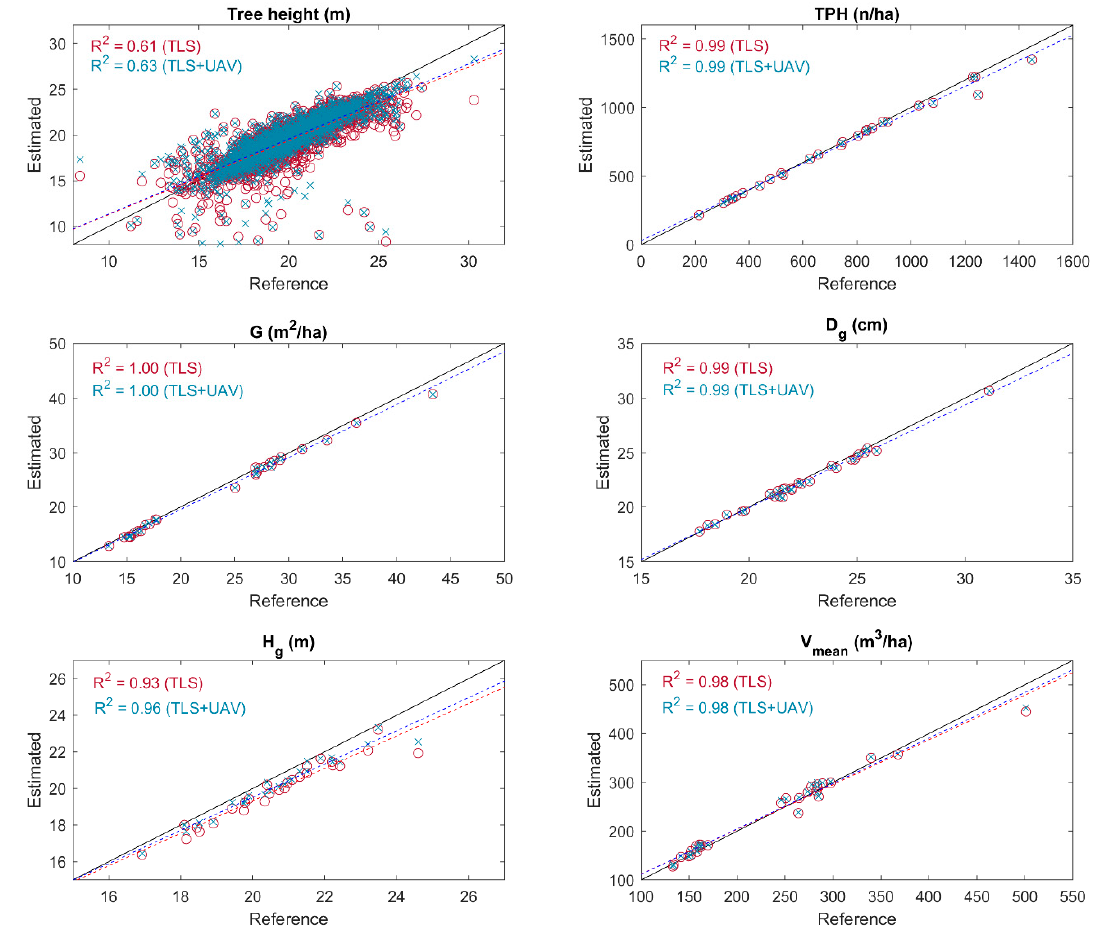
Figure 4. Coefficient of determination (R 2 ) between the reference and the estimated forest structural attributes, such as individual tree height, trees per hectare (TPH), basal area (G), basal-area weighted mean diameter (D g ), basal-area weighted mean height (H g ) and mean stem volume (V mean ) using the terrestrial laser scanning (TLS) and the combination of the TLS and the unmanned aerial vehicle (UAV) point clouds. The estimated values are based on the TLS and the multisensorial approach (TLS + UAV) and the reference values are based on the field inventory. The solid black line represents the 1:1 relationship between the reference and the estimated values.